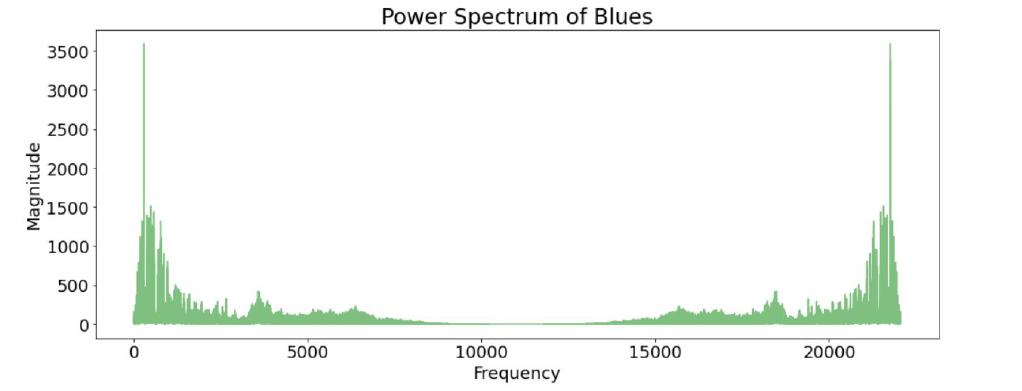
Figure 3. Blues music signal in the time domain.